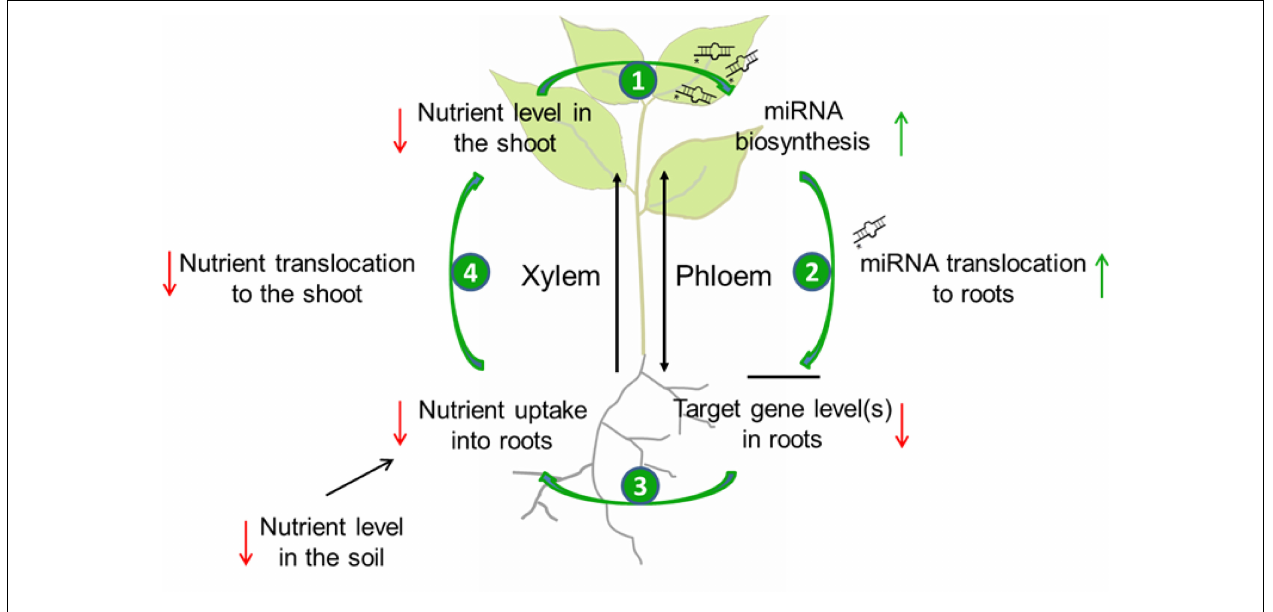
nutrient-responsive miRNAs (1) that will be translocated to the root via the phloem (2). In the root, this miRNA will post-translationally reduce the amount of its target mRNA(s). As a consequence, nutrient uptake will be activated (3), and also nutrient allocation to the shoot will be elevated (4) what allows the plant to optimize shoot development under nutrient